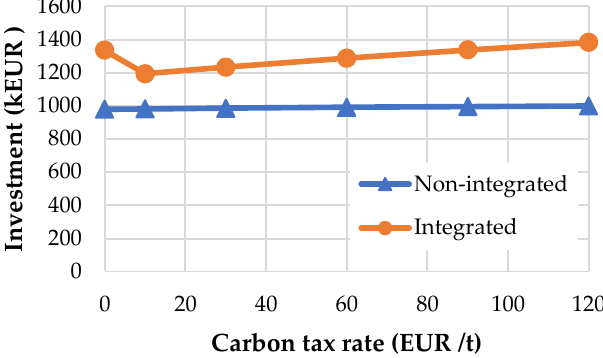
Figure 6. Investment at different values of the CO 2 tax rate.